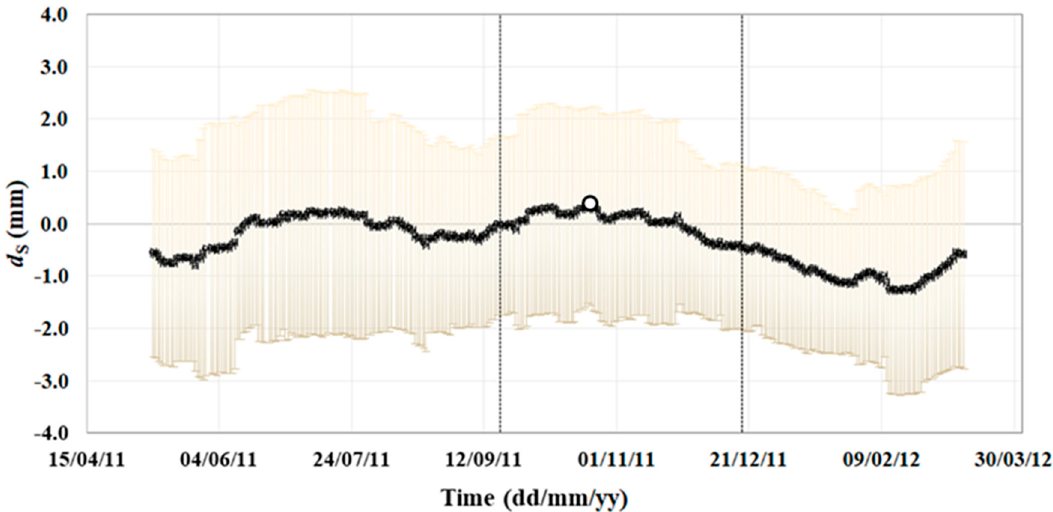
Figure 13. Temporal behavior of timely averaged GNSS displacements of the central section along S-axis (black dots) with over imposed ± the standard deviation within the 2 months moving window (yellow bars). Vertical dashed lines delimit a period of water use and no rainfall (on the left), a period of no water use and no rainfall (central); a period of no water use and rainfall (on the right). The white dot indicates d s occurring with minimum the water level.